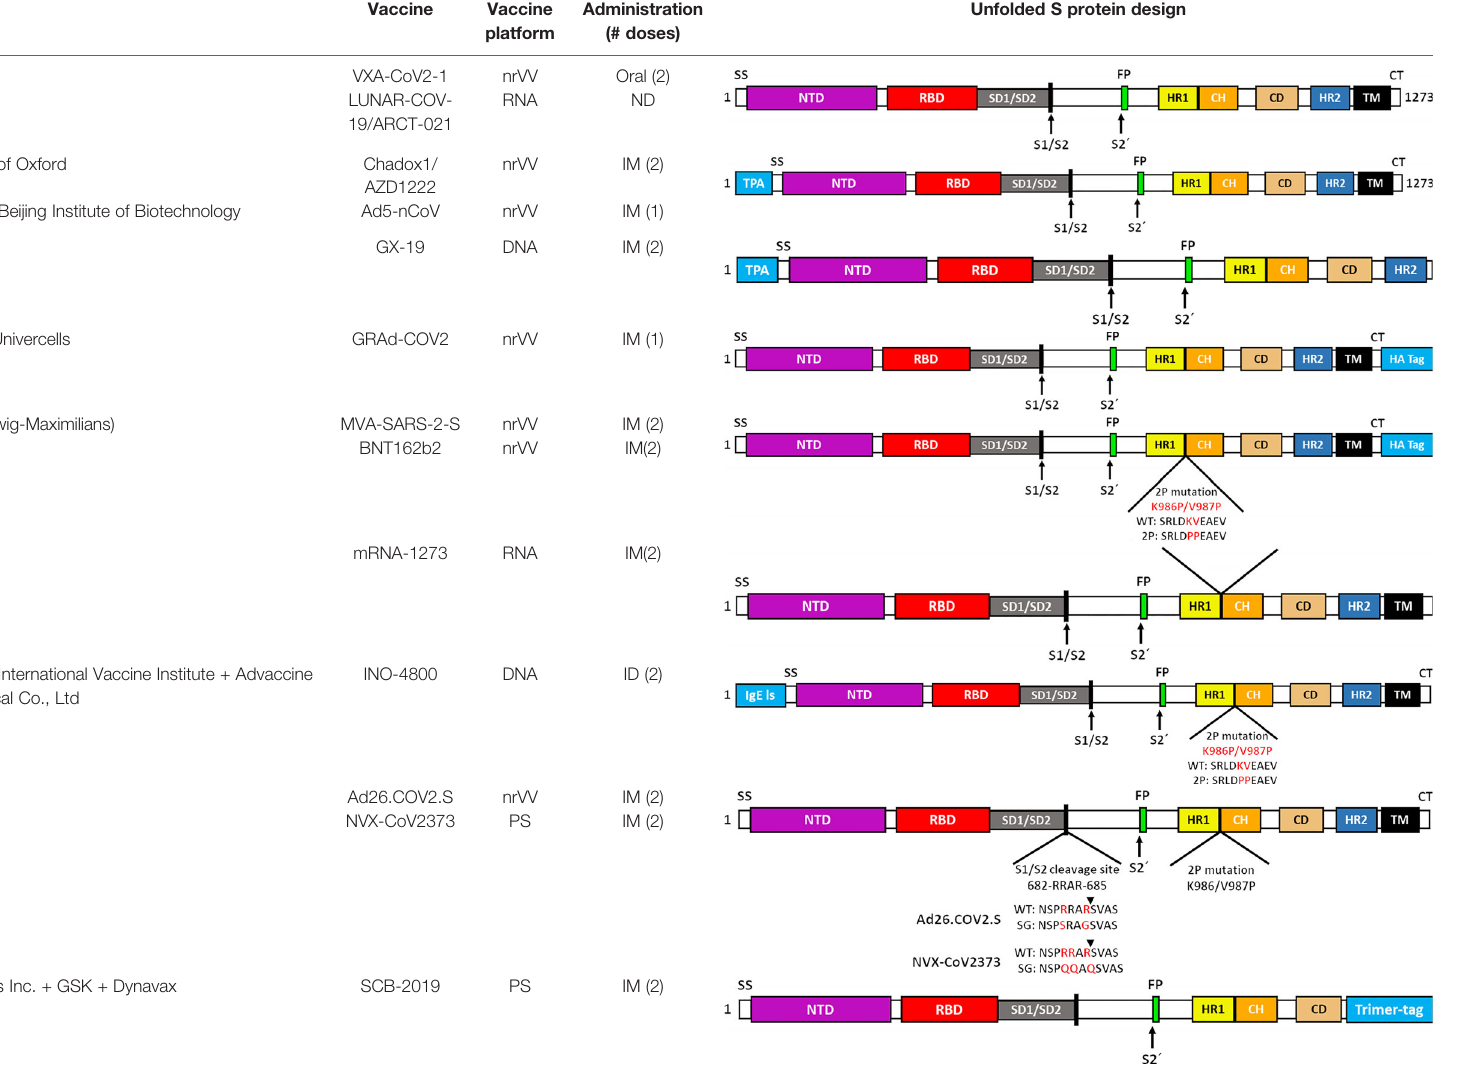
TABLE 1 | Summary of the redesign of the complete S glycoprotein used in vaccines against